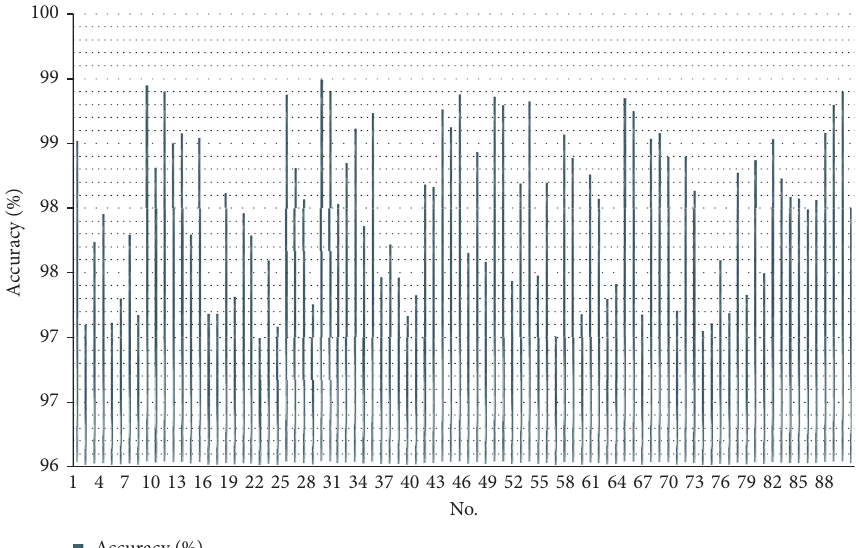
Figure 15: Statistical diagram of the accuracy of pedestrian